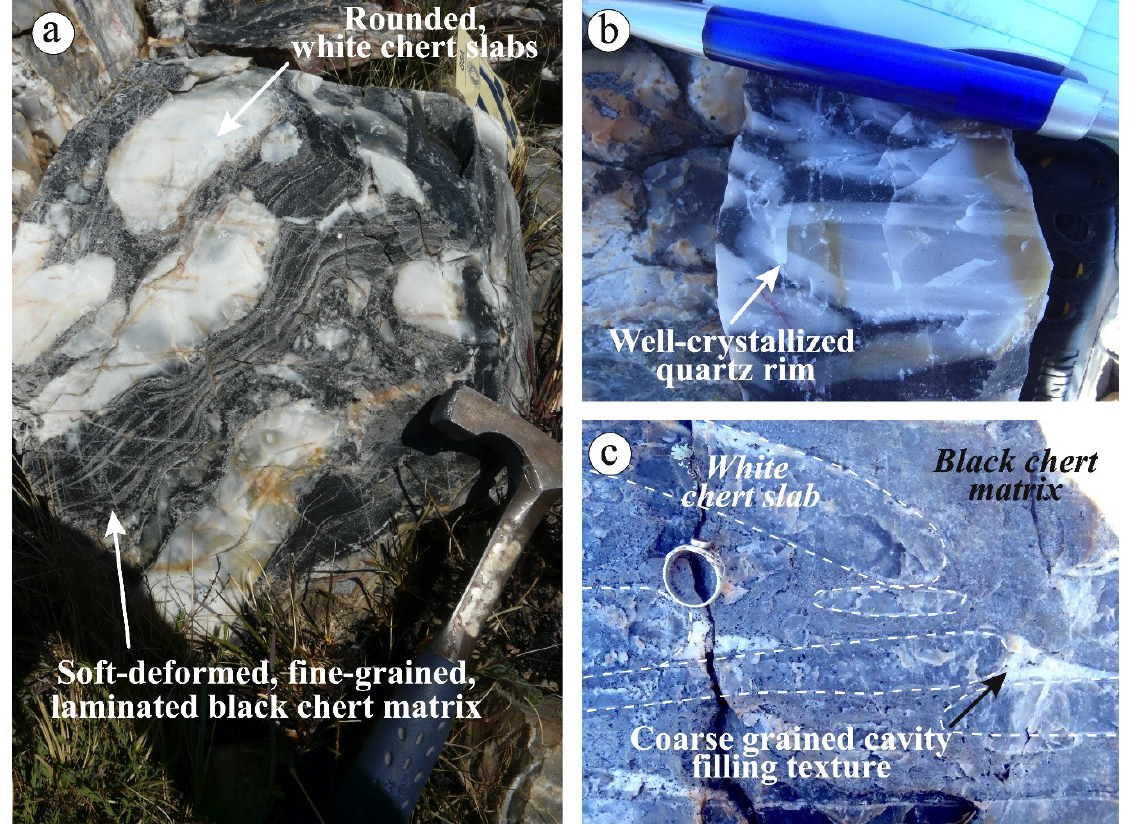
Figure 4. Details of slab conglomerates showing: ( a ) rounded white chert deposited in a soft deformed, fine-grained and laminated black chert matrix; ( b ) angular white chert slabs with a well-crystallized quartz aureole; ( c ) elongated white chert slabs and void-filling silica textures in a fine-grained black chert matrix.